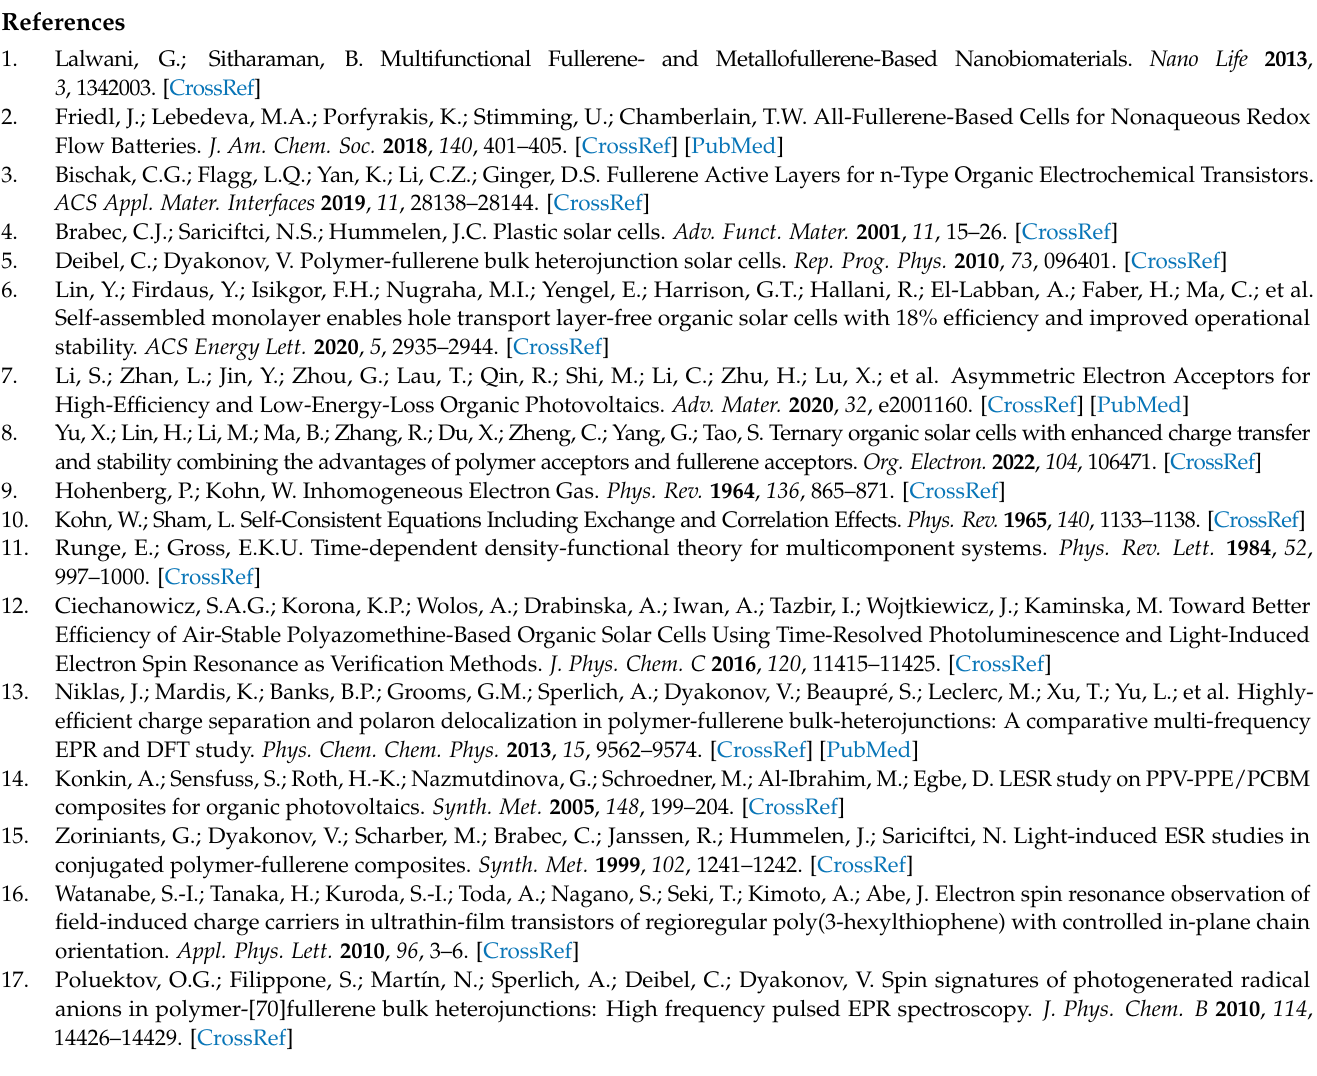
Table S6. Electrical parameters of manufactured solar